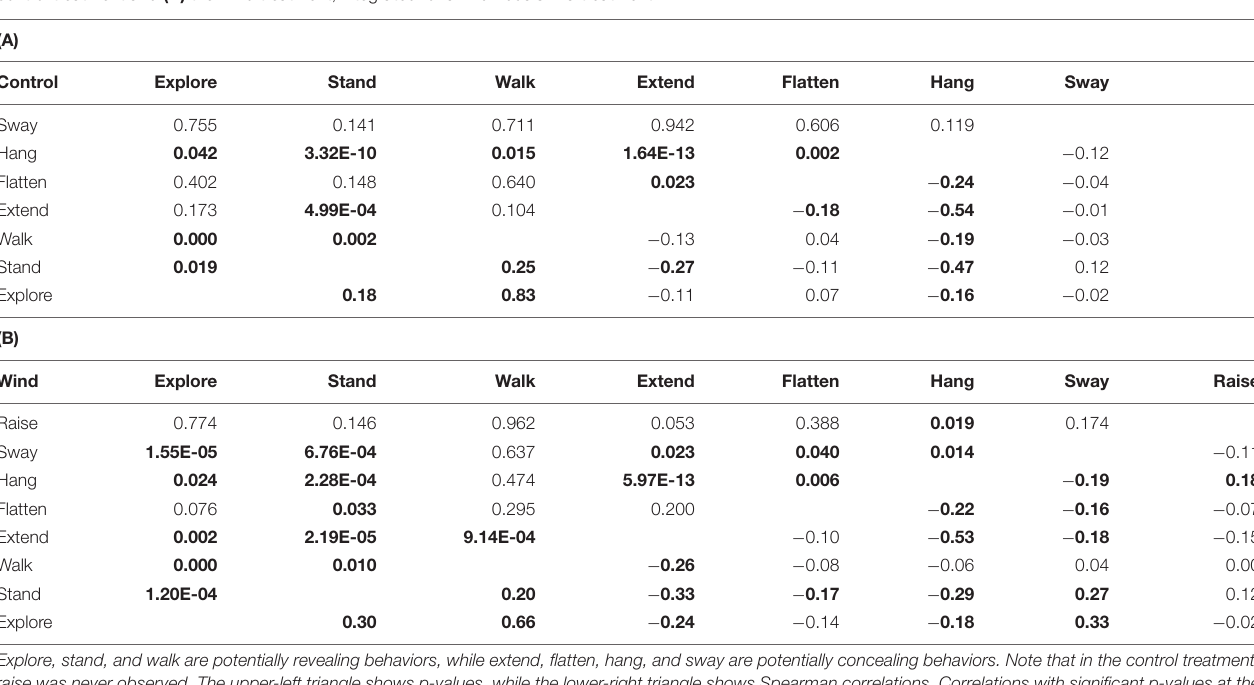
TABLE 5 | Pairwise correlations between the proportions of time spent on behaviors that significantly contributed to the distribution pattern during NMDS, for (A) the control treatment and (B) the wind treatment, integrated for all individuals in a treatment.